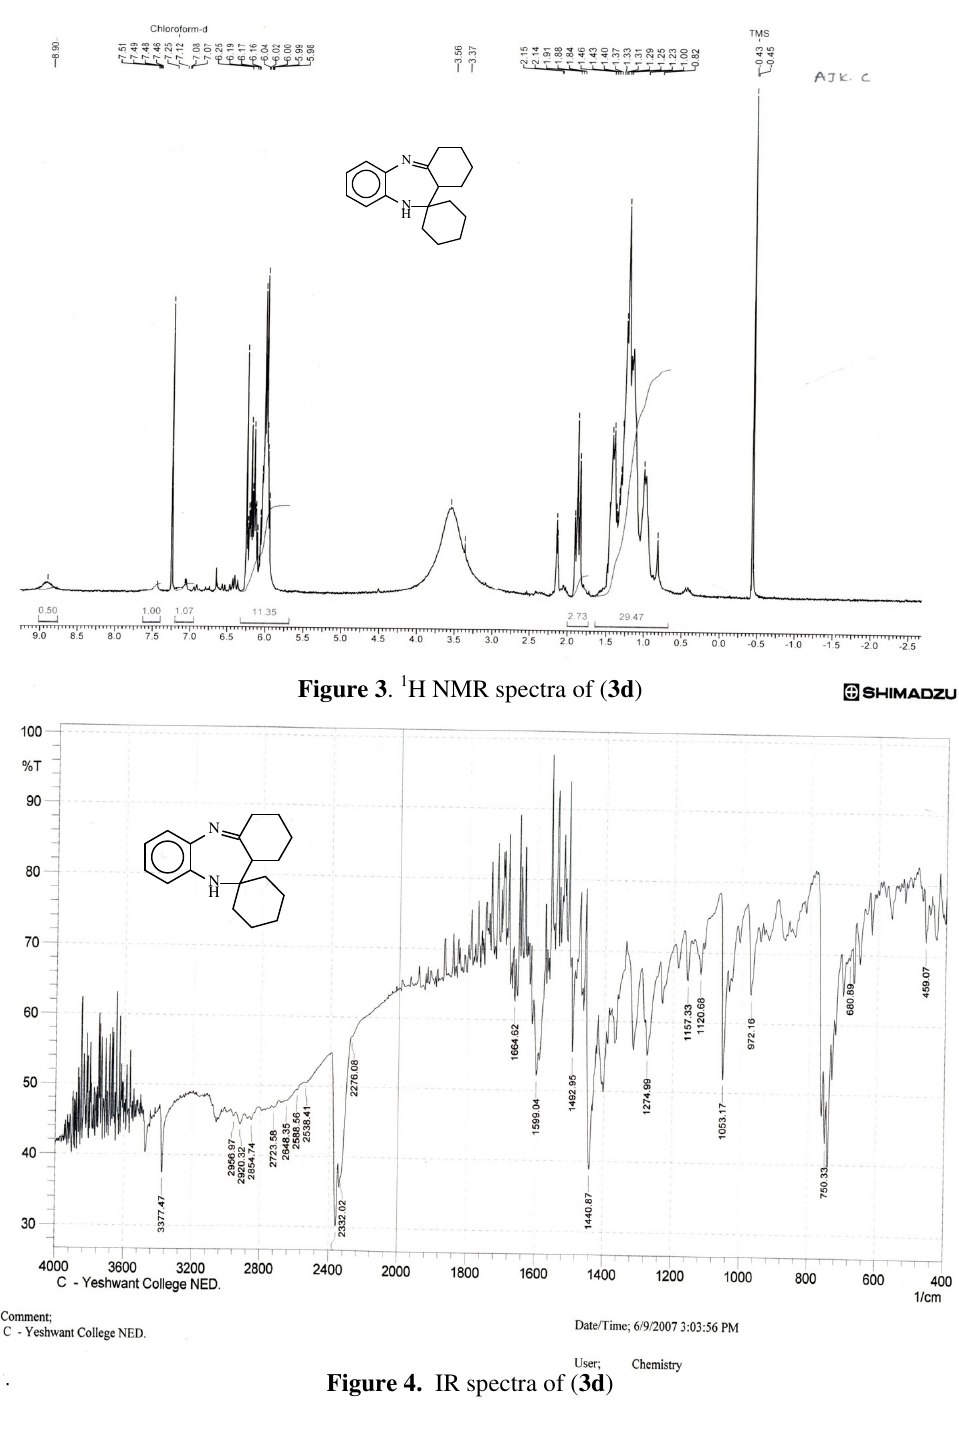
Figure 4. IR spectra of ( 3d